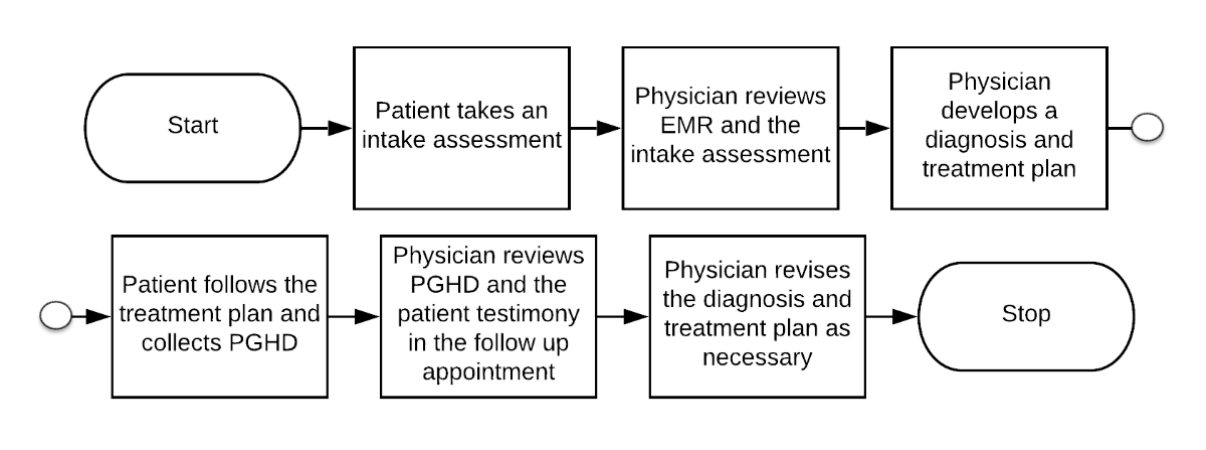
Figure 1. Simplified consolidate workflow diagram of psychiatrists and psychologists based on semistructured interviews. EMR: electronic medical record; PGHD: patient-generated health